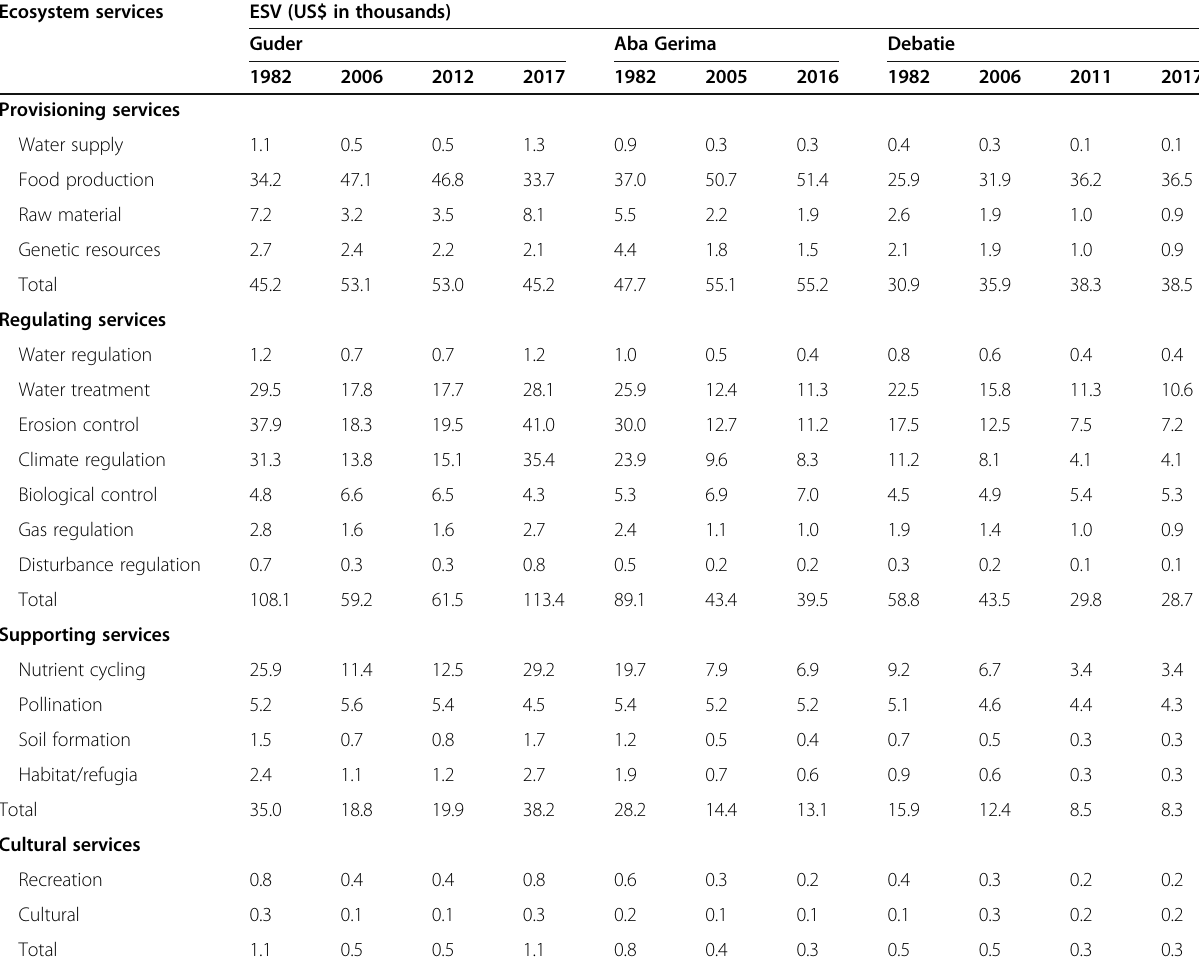
Table 5 Effects of land-use/land-cover (LULC) changes on individual ecosystem services from 1982 to 2016/17 in the study watersheds Ecosystem services